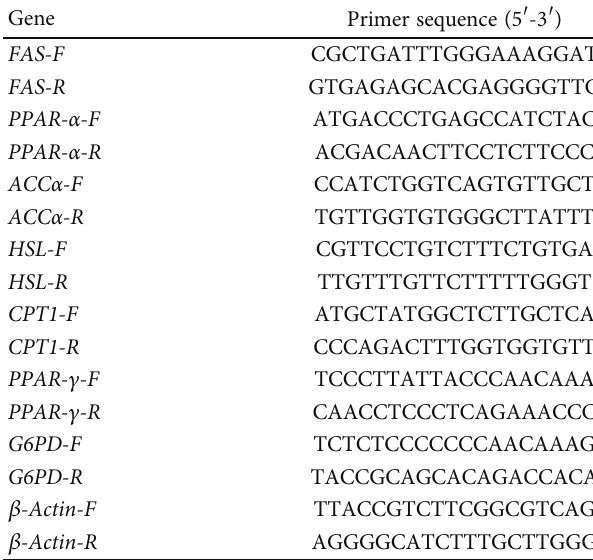
Table 2: Primer sequence. Gene Primer sequence (5 ′ -3 ′ )